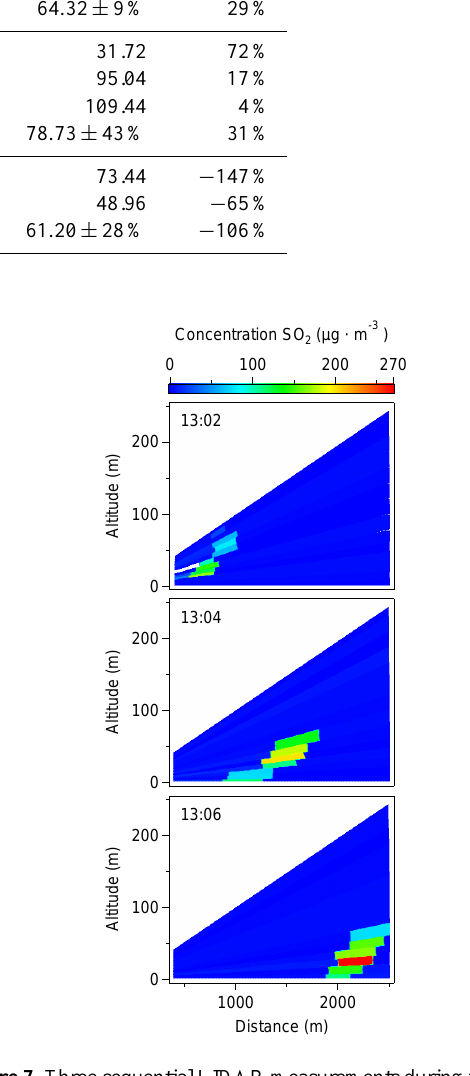
Figure 7. Three sequential LIDAR measurements during the depar- ture of Stena Hollandica on the 17 September 2009. The blue area is the area covered by the LIDAR